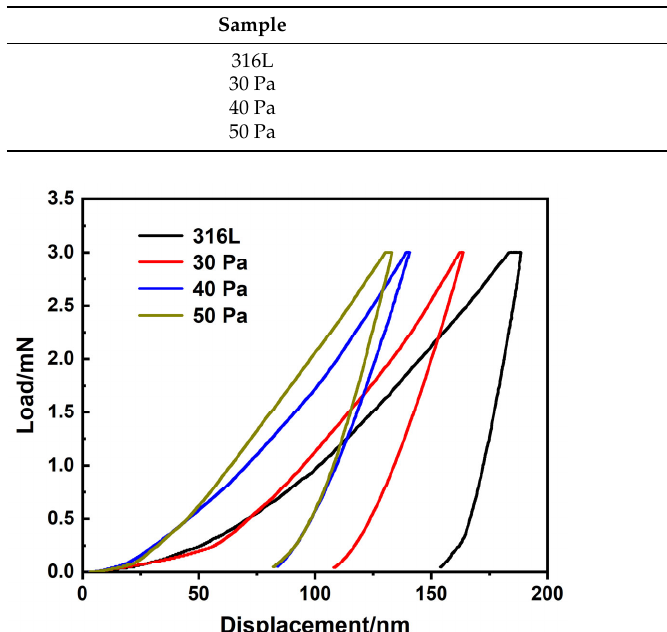
Table 3. Surface hardness of 316L substrate and alloying layers at 30 Pa, 40 Pa, and 50 Pa of pressure.